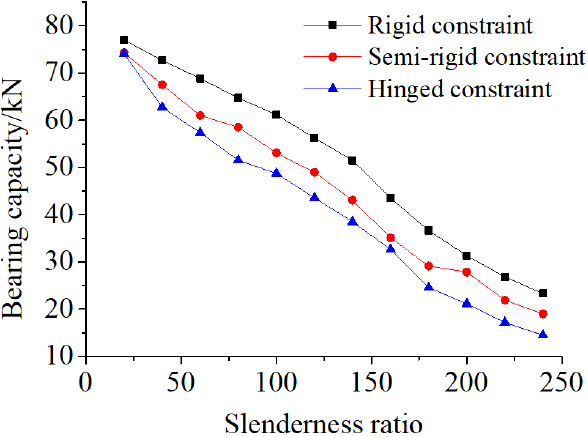
Figure 19: Angle stability capacities under different